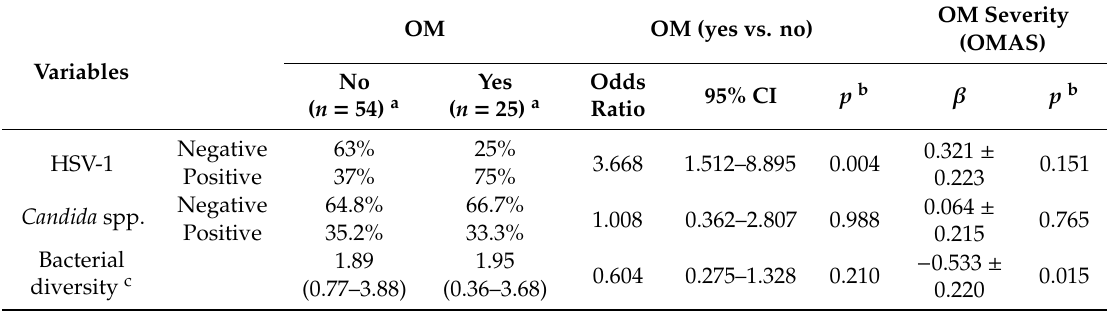
Table 2. Associations of post-chemotherapy microbial factors with the incidence and severity of oral mucositis in patients undergoing autologous hematopoietic stem cell transplantation.